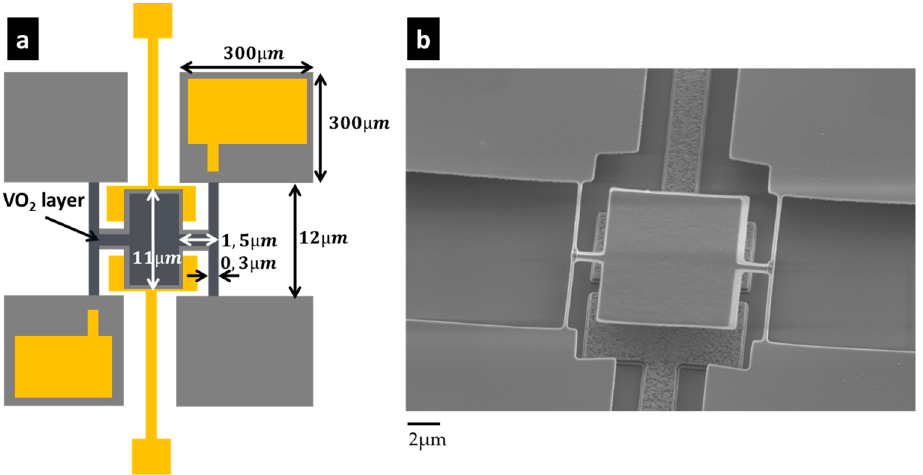
Figure 11. Torsional resonator design: ( a ) Schematics of the design; ( b ) SEM image of a typical pixel with a VO 2 layer on top of both the plate and torsional rods, plus partially on the insulation legs.